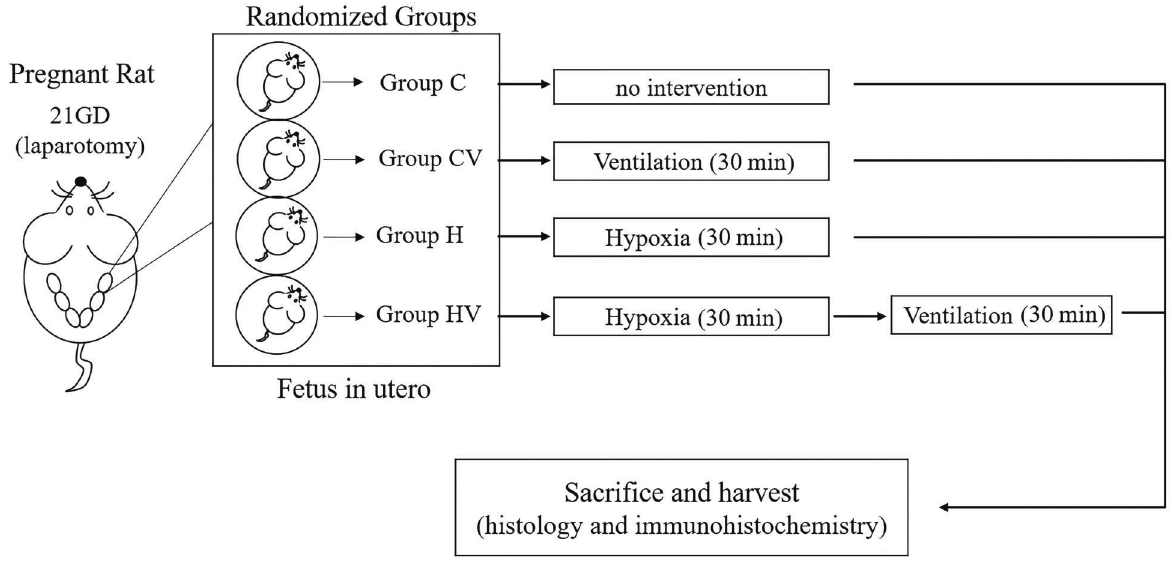
Figure 1. Study design. GD: gestation day; C: control; CV: control submitted to mechanical ventilation; H: hypoxia; HV: hypoxia sub- mitted to mechanical